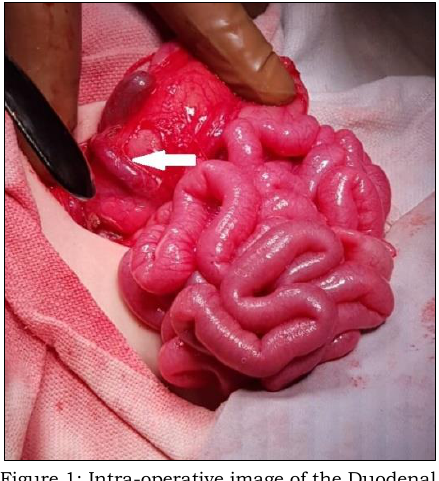
Figure 1: Intra-operative image of the Duodenal Atresia with pre duodenal portal vein